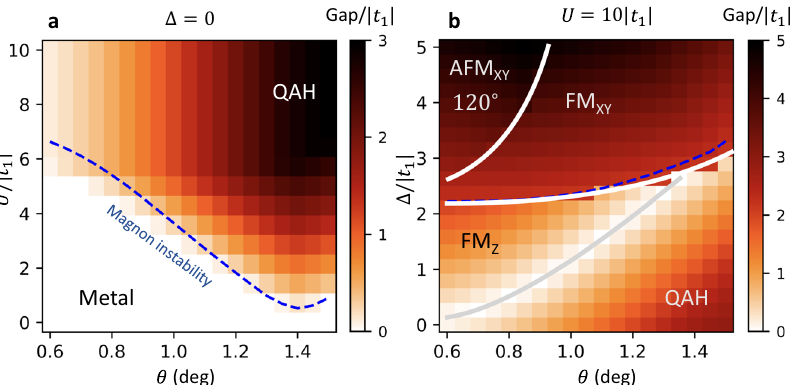
Fig. 5 Numerical solution of the self-consistent Hartree − Fock approximation. The phase diagram is shown as a function of the twist angle and ( a ) interaction strength at fi xed displacement fi eld Δ = 0, or b displacement fi eld at fi xed interaction strength U = 10 ∣ t 1 ∣ , including up to fi fth nearest neighbor hopping terms. The insulating phases denoted by QAH, FM z , 120 ∘ AFM xy , and FM xy are described in the main text. The dashed blue line shows the boundary of the FM z phases determined by the fi rst magnon instability. The colors indicate the charge gap. Hartree − Fock calculations were done with a ffiffiffi ffiffiffi p p ´ 3 3 unit cell of 6 atom sites, and a 30 × 30 grid of ( k )